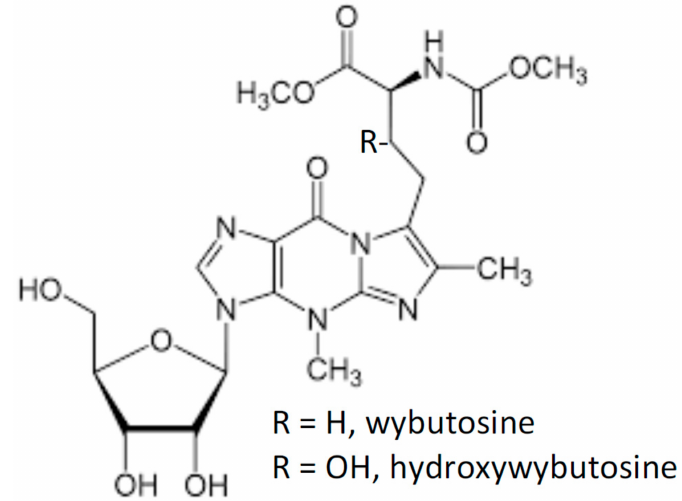
Figure 1. Wybutosines, guanosine